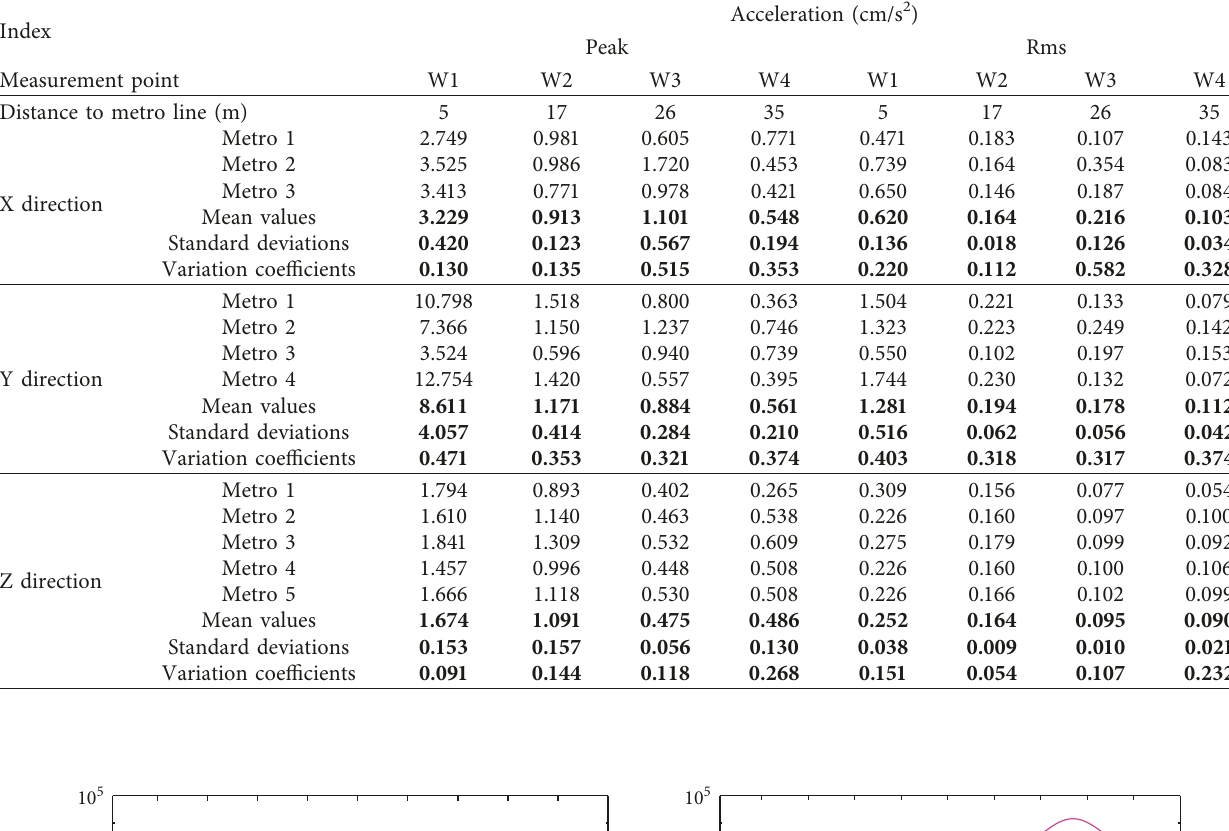
Table 2: Mean values, standard deviations, and variation coefficients of peak and Rms values of accelerations induced by metros in three directions.